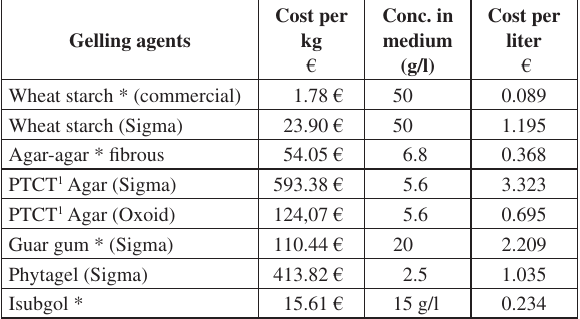
Table 1. Comparison of the costs of media gelled with different gelling agents. The gelling agents, used in our experiments marked by *. Gelling